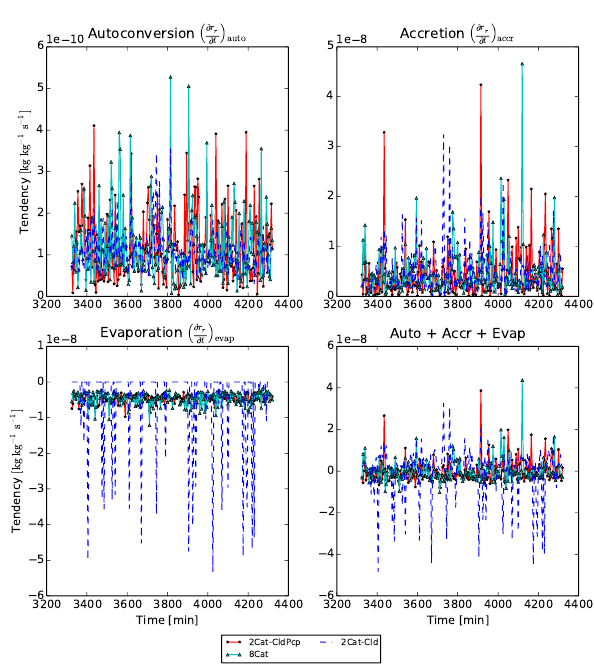
Figure 2. RICO: time-series plots of the four tendencies at the im- portance sampling level. The simulations in these plots use 32 sam- ple points, and the plots show minutes 3321 to 4320 of the simu- lations. To improve readability, the LH-only method is not plotted. The evaporation tendencies are much more noisy in the 2Cat-Cld method than in the 2Cat-CldPcp or 8Cat